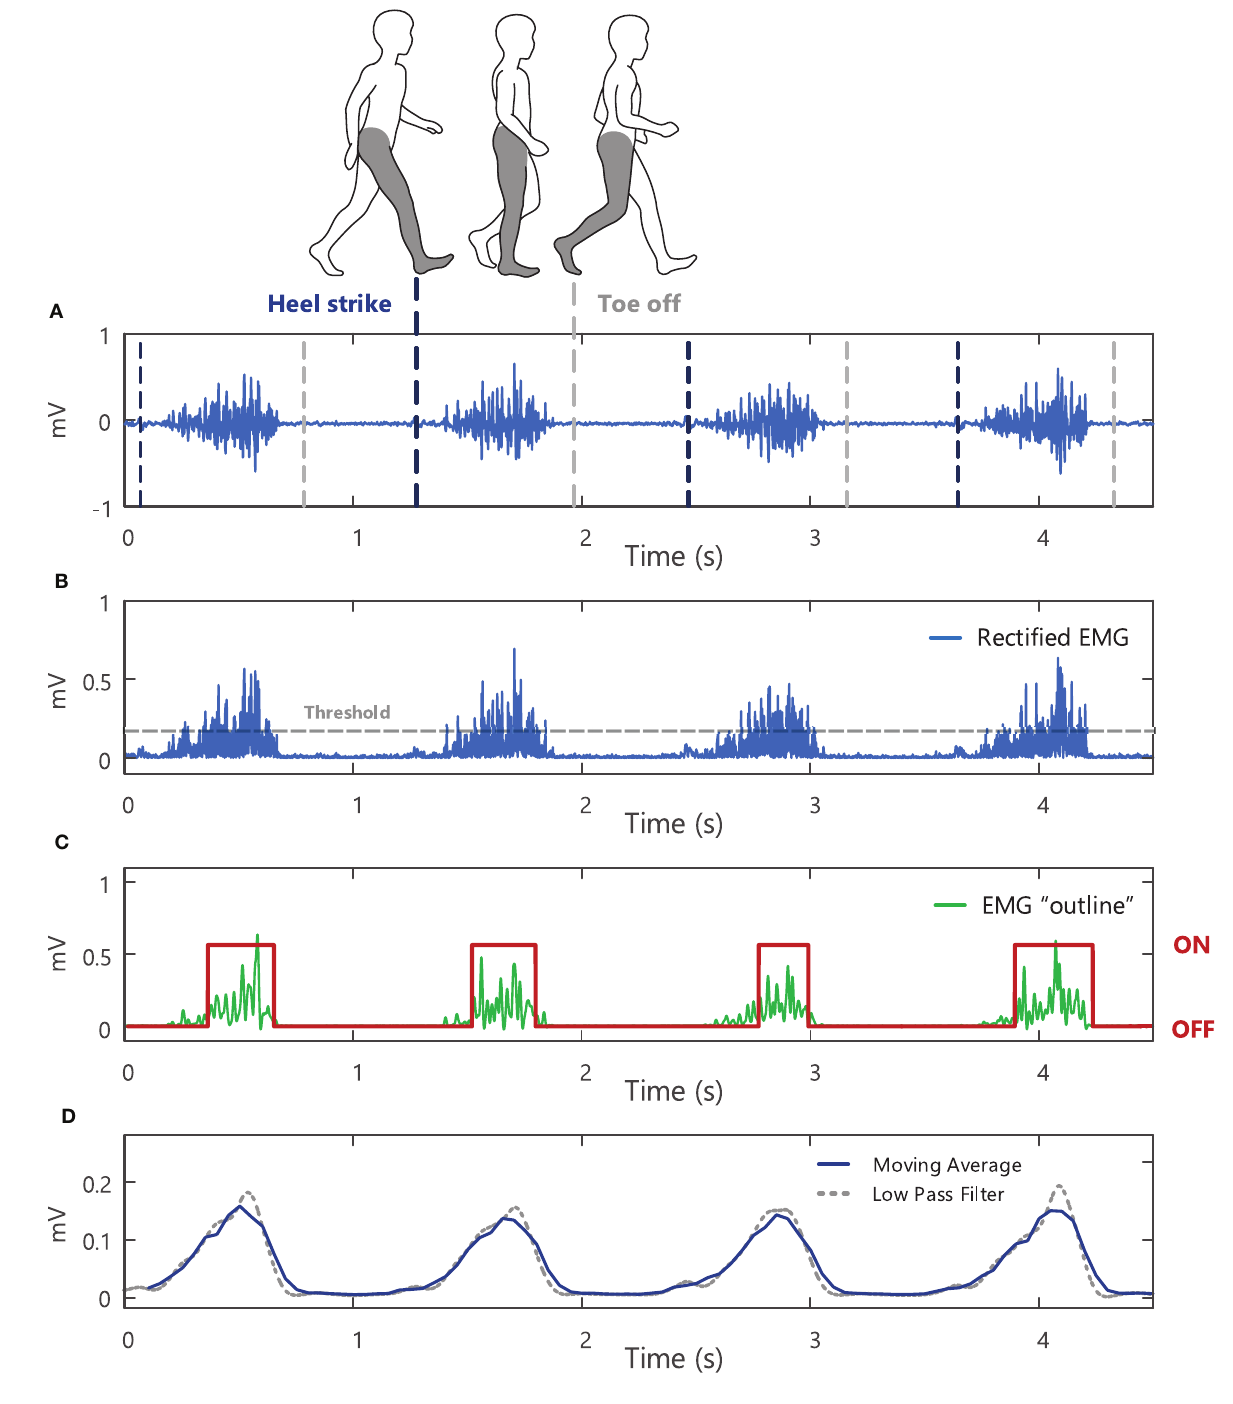
FIGURE 11 | (A) A raw surface EMG signal recorded from the soleus muscle during walking, with vertical lines to indicate where heel strike and toe off occur during the gait cycle. (B) The absolute value or rectified surface EMG signal. (C) The outline or “shape” of the rectified EMG signal obtained by low-pass filtering the EMG signal at 50Hz (after applying the Teager-Kaiser Energy Operator to the signal) with muscle onset times shown in red. (D) A 0.2-s moving average of the rectified surface EMG signal (with 25% overlap) and an average obtained using a 5-Hz low-pass filter (with the filter applied twice so that there is no time delay in the filter output, see Example (xiv) in Tutorial